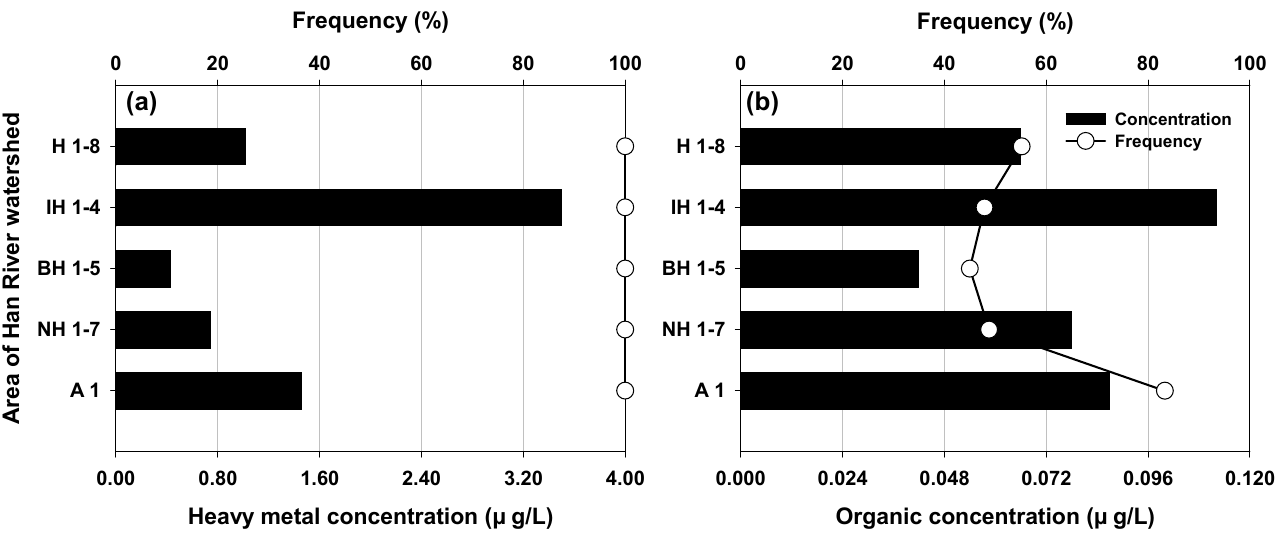
Figure 3. Concentrations and detection frequencies of ( a ) heavy metal and ( b ) organic compounds in five areas of the Han River watershed.